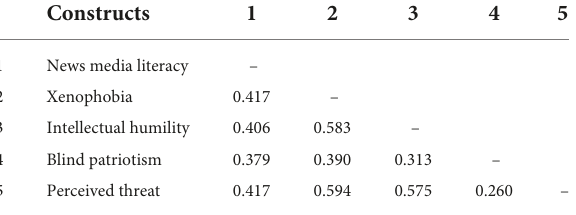
TABLE 4 Heterotrait-monotrait ratio of correlations result.